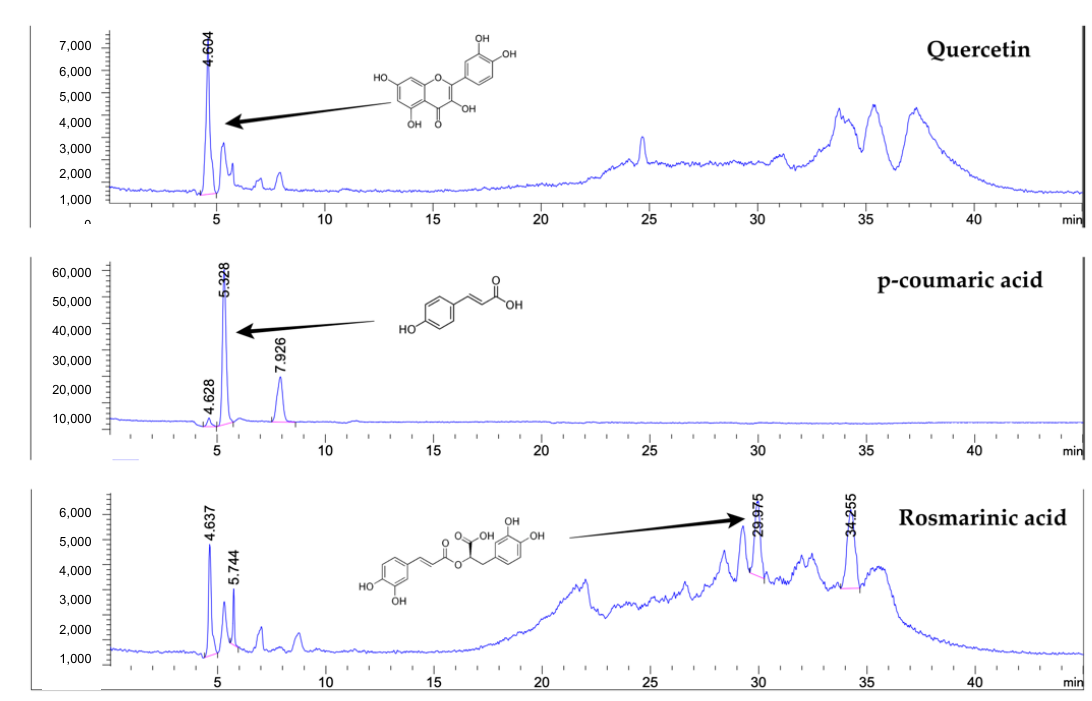
Figure 1. Chromatogram of bioactive compounds in shallot extract analyzed by liquid chromatography–mass spectrometry (LC-MS).